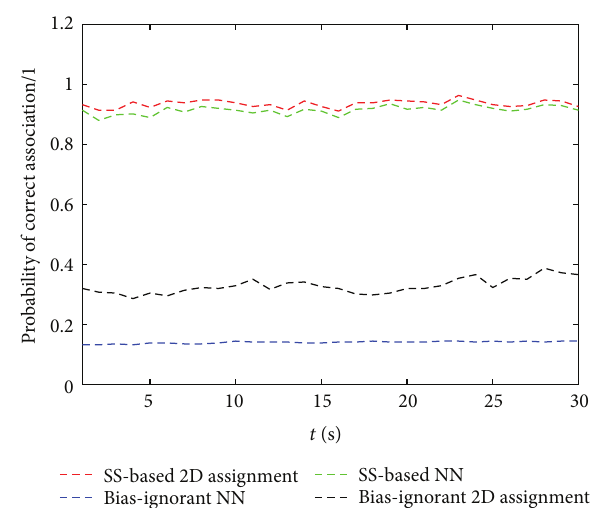
Figure 6: Probability of correct association via the whole tracking